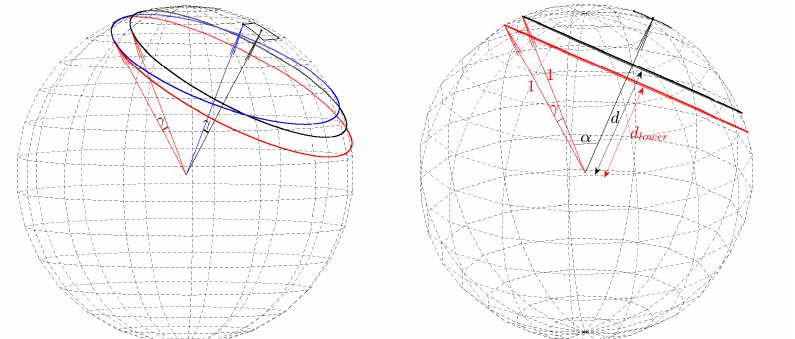
Figure 12. ( Left ) The angle γ between the (red) radius vector pointing at a critical point and its respective closest point on the common secondary circle (black) is equal to the angle between the radius vector (black) corresponding to the secondary point at the center of the cell ( θ max , ϕ max ) and the radius vector (blue) associated with a corner point. ( Right ) The common secondary circle (black) and one of the critical circles (red). The spherical radius vector defined by the angular coordinates ( θ max , ϕ max ) of the secondary point passes through the centers of the common secondary circle and the two critical circles, and this radius vector is perpendicular to the planes containing the circles. d and d lower are the distances of the common secondary circle and the (lower) critical circle from the origin of the sphere,